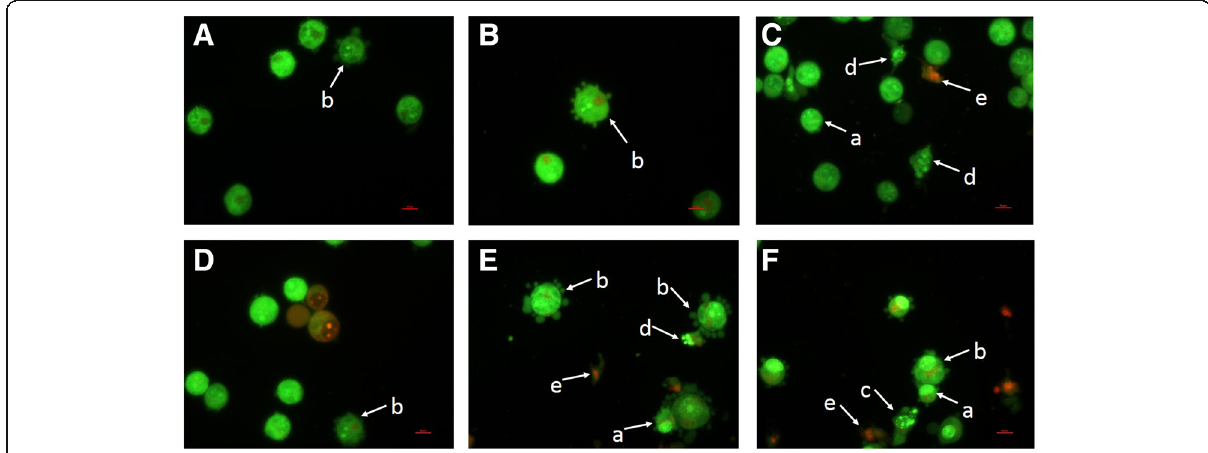
Fig. 5 Apoptosis induction by PM of Lactobacillus plantarum I-UL4 on MCF-7 cells. Panel a : 15% (v/v), 24 h; b : 15% (v/v), 48 h; c : 15% (v/v), 72 h; d : 30% (v/v), 24 h; e : 30% (v/v), 48 h; and f : 30% (v/v), 72 h. Morphological changes following exposure to PM produced by L. plantarum I-UL4 were typical of apoptosis, i.e. cell shrinkage (a), membrane blebbing (b), perinuclear chromatin condensation (c), apoptotic bodies formation (d), and secondary necrotic cells (e). (Bar: 10 μ m; magnification: